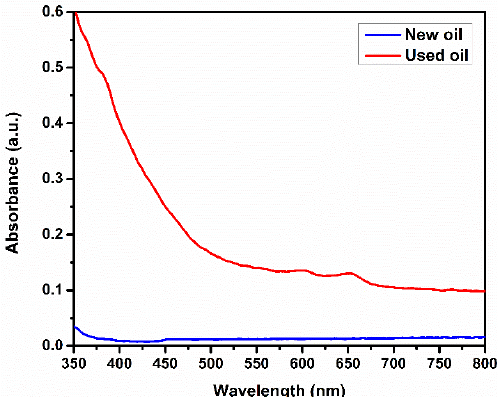
Figure 5. Absorbance spectra of new and used oil.